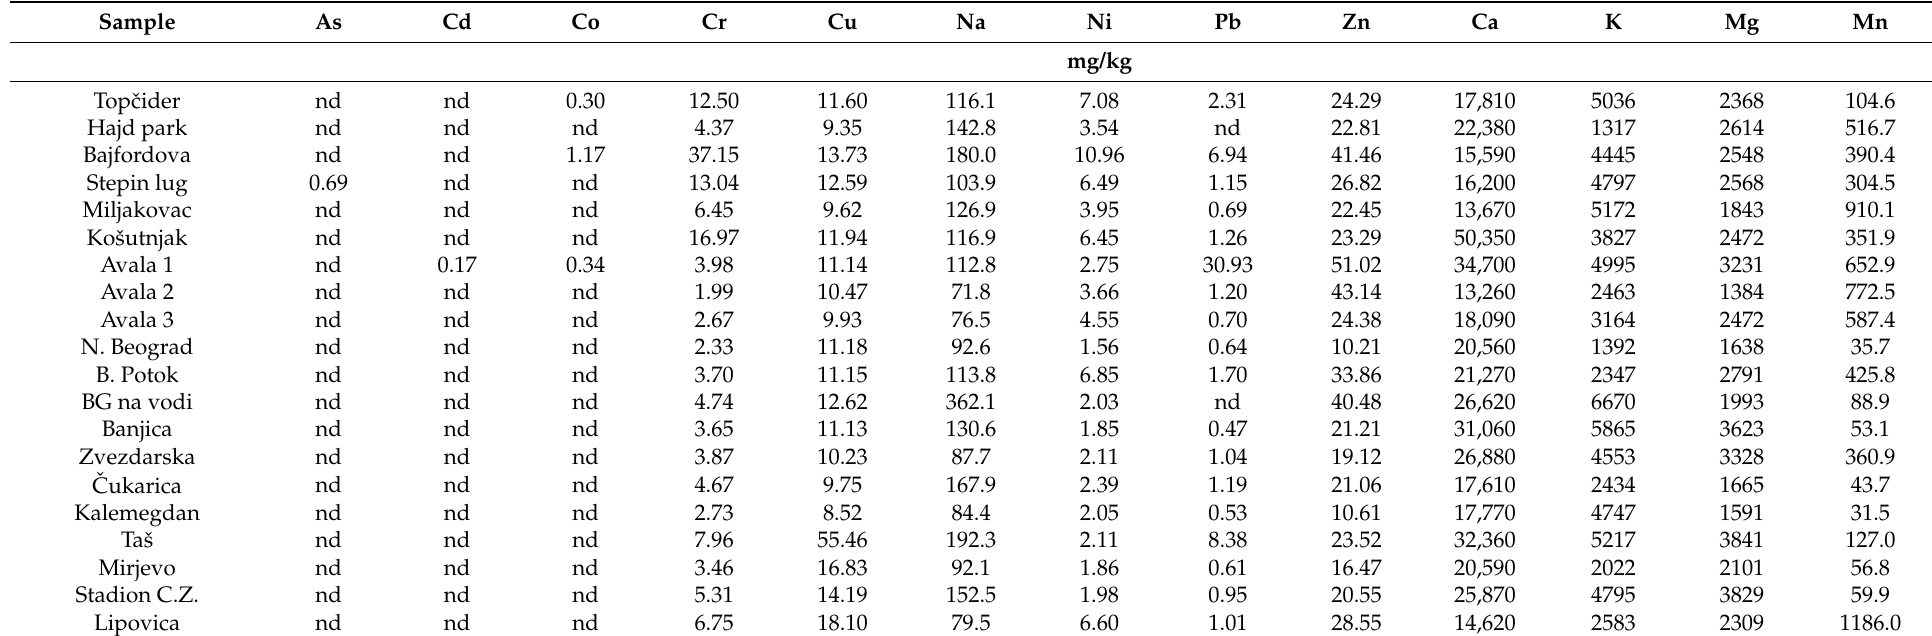
Table 4. Content of As, Cd, Cr, Co, Cu, Na, Ni, Pb, Zn, Ca, K, Mg, and Mn (mg/kg) in